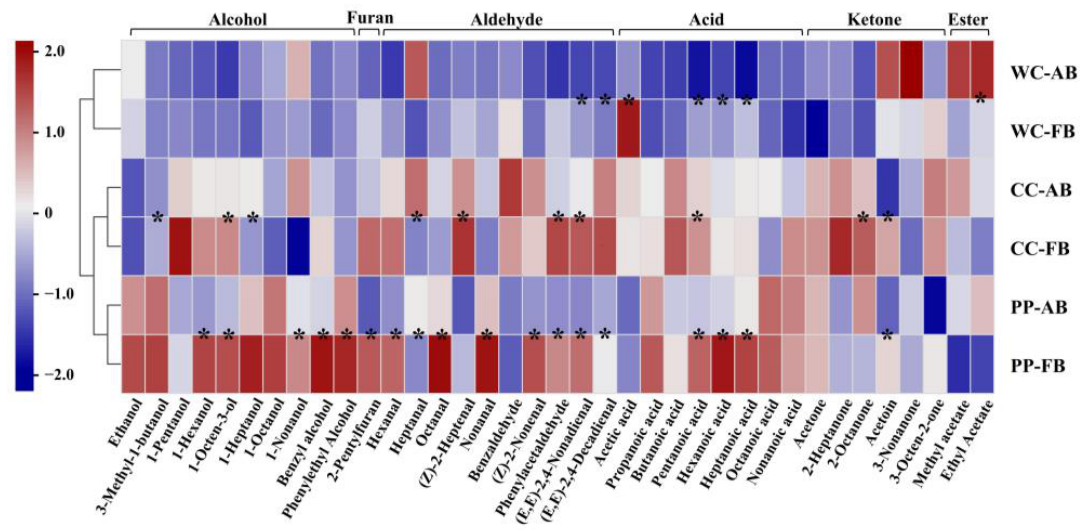
Figure 6. Comparison of volatile compounds in alkali-added and alkali-free CSBs fermented using synthetic microbial community starters. Pearson correlation with hierarchical clustering among the CSB samples was applied. WC-FB, CC-FB, and PP-FB indicate alkali-free CSBs fermented by synthetic microbial community starters containing Weissella cibaria , Companilactobacillus crustorum , and Pediococcus pentosaceus , respectively. WC-AB, CC-AB, and PP-AB symbolize alkali-added CSBs fermented by synthetic microbial community starters containing W. cibaria, C. crustorum, and P. pentosaceus , respectively. * p < 0.05.